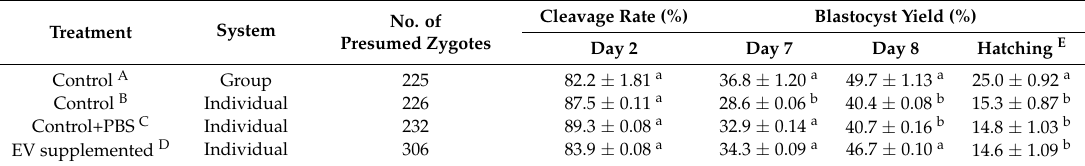
Table 3. Blastocyst development and hatching rate of individual cultured bovine embryos after EV supplementation.